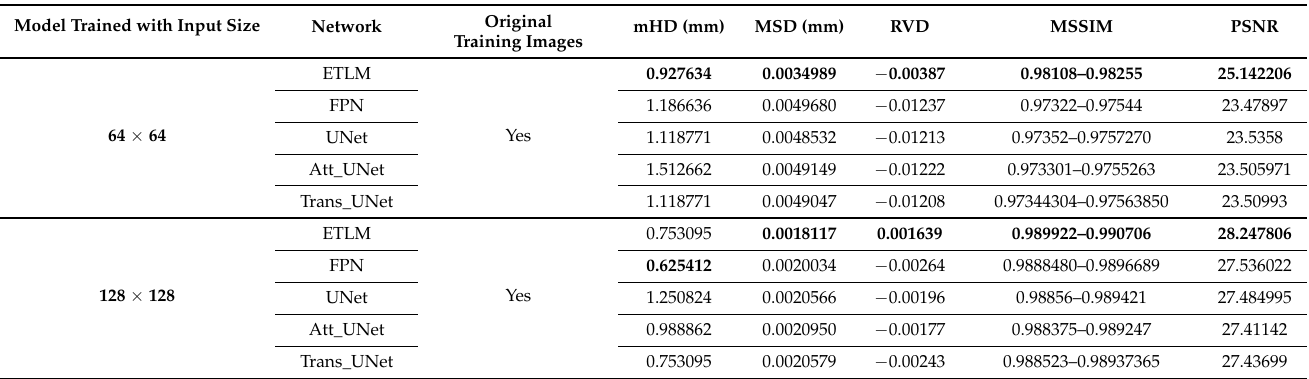
Table 8. Level two: predicted mask (post-processed) quality assessment for models with various input sizes.